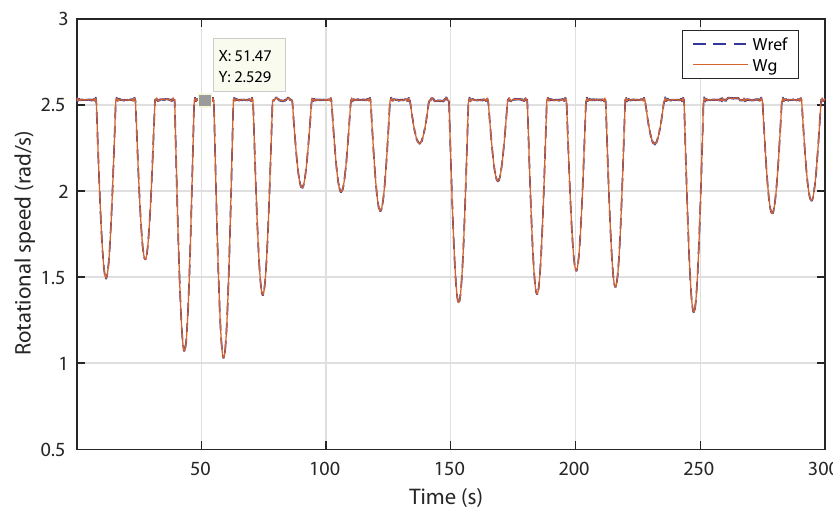
Figure 19. Scenario 2: Generated reference and actual rotational speed.